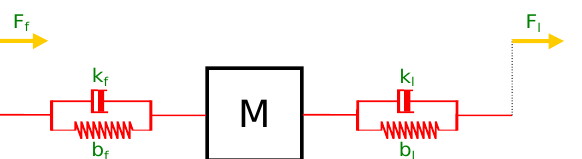
Figure 6. Simplified mathematical system, where F f , F l are the follower and leader forces, respec- tively; K f , K l are the follower and leader muscle stiffness, respectively; b f , b l are the follower and leader damping factor, respectively; and M is the mass of the shared